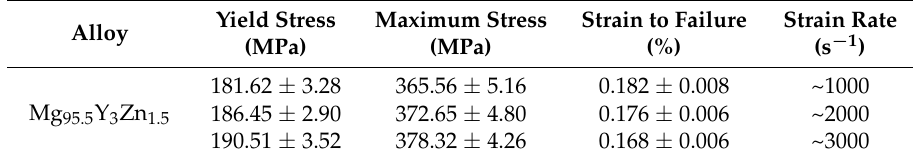
Figure 4. True stress-strain curves of the as-cast Mg 95.5 Y 3 Zn 1.5 alloy tested at the strain rates of ~1000 s − 1 , ~2000 s − 1 , and ~3000 s − 1 . Table 2. Mechanical properties of the as-cast Mg 95.5 Y 3 Zn 1.5 alloy under the strain rate from ~1000 s − 1 to ~3000 s − 1 .